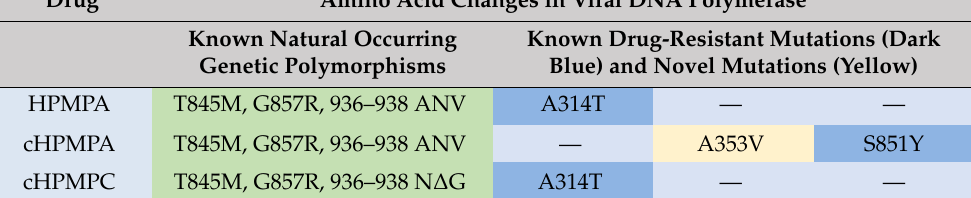
Table 1. Identification of amino acid changes in the viral DNA polymerase following selective pressure with HPMPA, cHPMPA, and cHPMPC in VACV Lederle strain. Drug Amino Acid Changes in Viral DNA Polymerase Known Natural Occurring Known Drug-Resistant Mutations (Dark Genetic Polymorphisms Blue) and Novel Mutations (Yellow) HPMPA T845M, G857R, 936–938 ANV A314T — — cHPMPA T845M, G857R, 936–938 ANV — A353V S851Y cHPMPC T845M, G857R, 936–938 N ∆ G A314T —